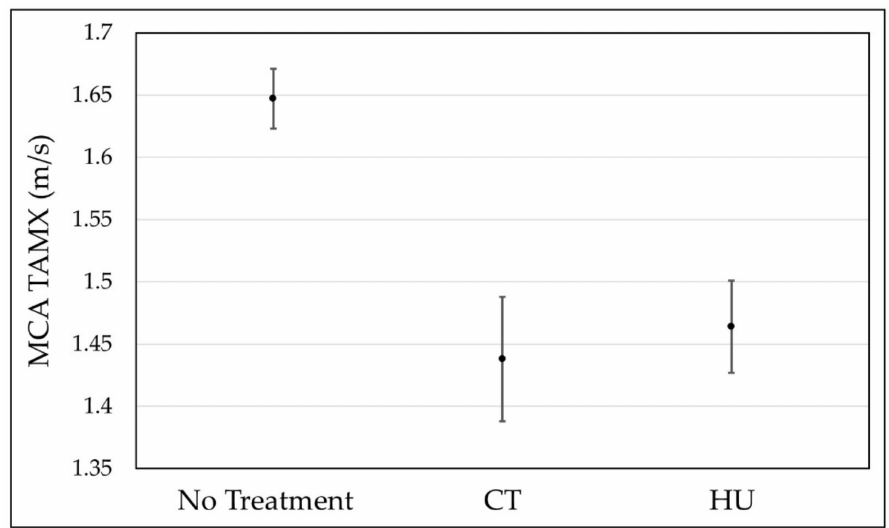
Figure 3. Mean MCA TAMX velocities—controlled for age. Graphic depiction of least squares means estimates for the three treatment groups, accounting for age as a covariate. The black dots indicate Mean MCA TAMX velocities, and the vertical lines indicate 95% confidence intervals. Age at time of TCD was higher for CT (9.67 years) and HU (8.75 years) treatment groups compared with no treatment (6.92). Because increasing age is associated with improved cerebral dynamics (i.e., lower TAMX velocities), performing the analysis with age as a covariate was vital. While accounting for age, the MCA TAMX values as measured using TCDs were significantly lower for both the CT and HU groups.